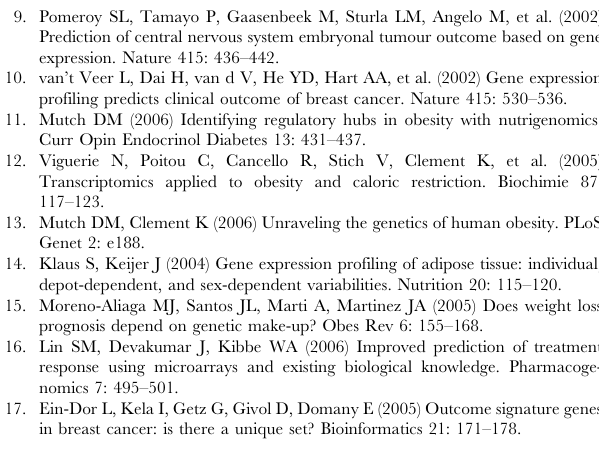
Table S2 Gene lists used for the top-down analyses. The gene lists indicate the 34 genes identified with SAM and the top 100 genes identified by Fisher or Student’s t-test analyses. SAM, significance analysis of microarrays; FDR, false discovery